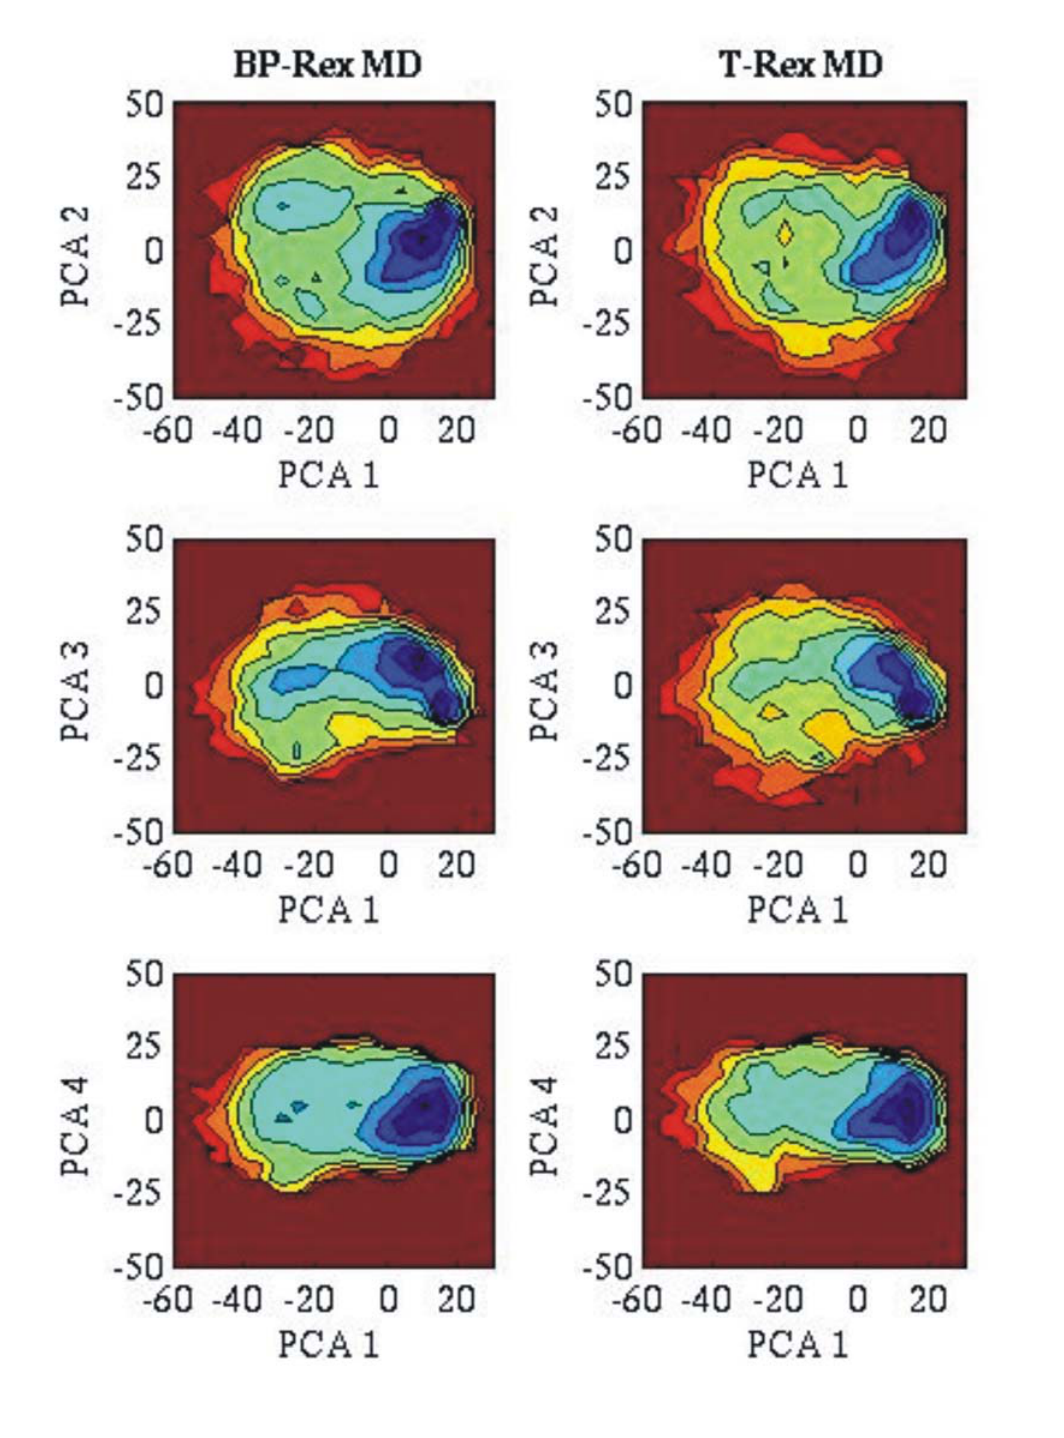
Figure 3. Projection of sampled states (in reference replicas) on 2-dimensional planes spanned by PC 1 (x-axis) and PCs 2-4 (y-axis). The PCs were obtained from the analysis of the BP-RexMD simulations (reference replica). The projected distribution is shown as the free energy contour plot (logarithm of density, blue color indicates favorable